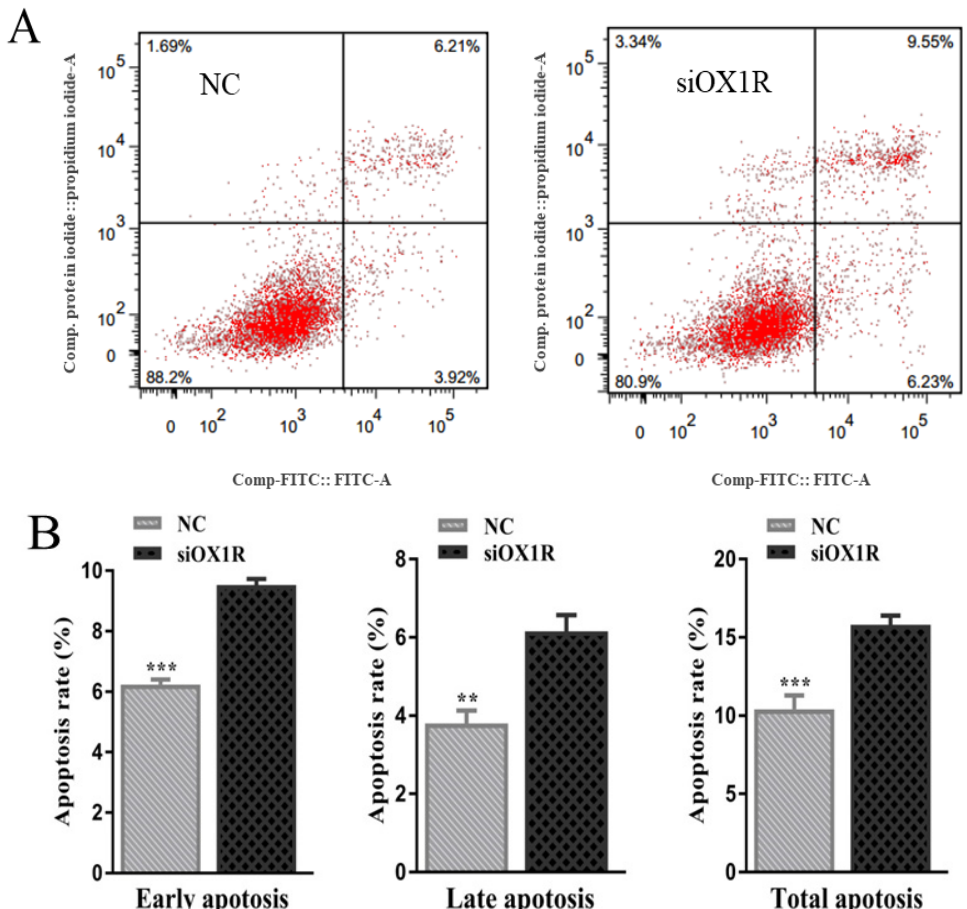
Figure 3. Downregulation of OX1R promoted apoptosis in mouse primary GCs. ( A ) Following the transfection with siOX1R and NC for 48 h, apoptosis in GCs was determined using flow cytometry. ( B ) The percentage of apoptosis was analyzed separately for early (lower right quadrants), late (upper right quadrants), and total apoptosis. The results are presented as the means ± SEM of three independent experiments. Different superscripts represent the level of significance between NC and siOX1R (** p < 0.01, *** p < 0.001). OX1R, orexin receptor type 1; NC, negative control; GCs, granulosa cells; siOX1R, orexin receptor type 1 siRNA.